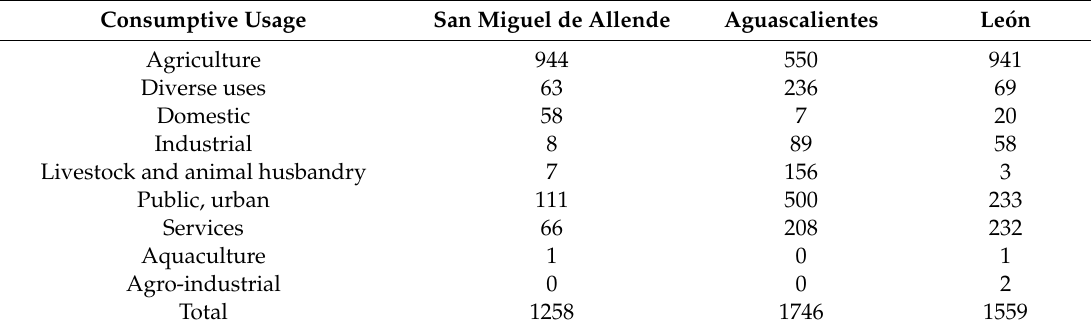
Table 1. Comparison of consumptive usages in three Mexican cities (in number of titles assigned to each consumptive